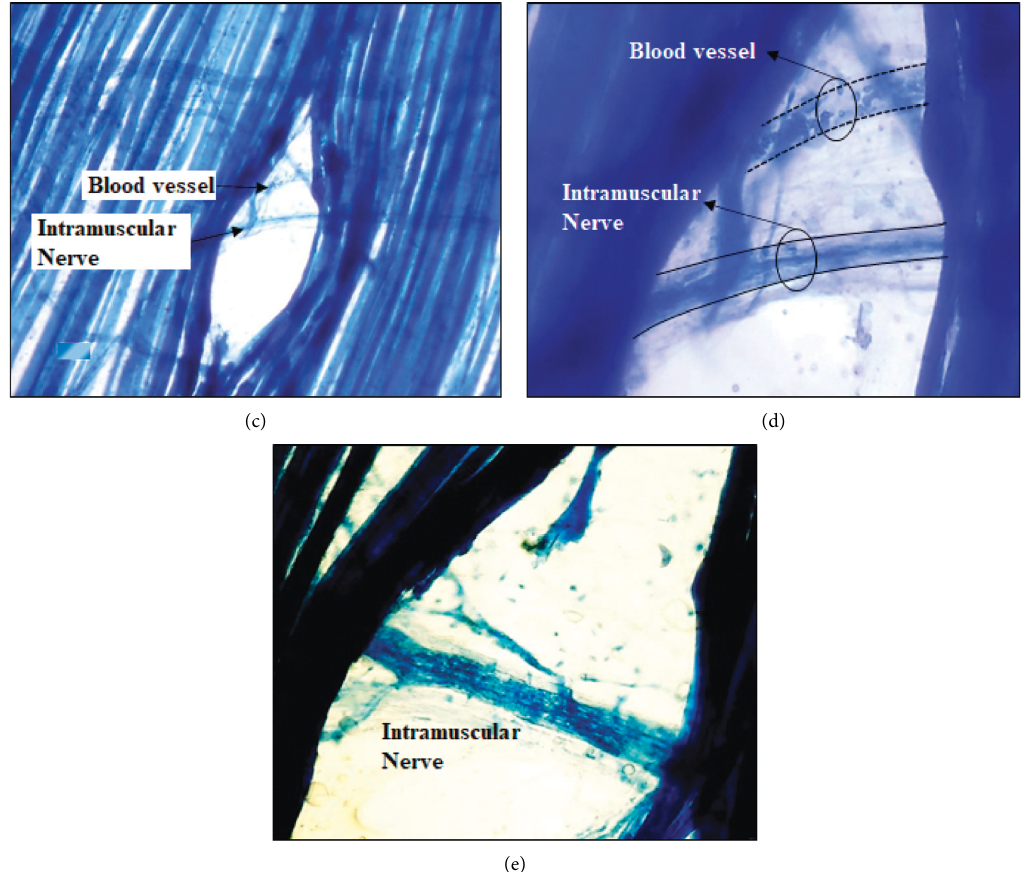
Figure 2: Ex vivo dry needling in LAL muscle with fibers with contraction knots. (a) Thirty minutes after a subcutaneous administration of neostigmine, the muscle shows several knots of contraction (arrows). (b) Several repeated punctures on the muscle were performed. Note that punctures were not performed at the same point. The needle separates many muscle fibers, and many others are injured (initial magnification: 100x). (c) Details of a puncture. Vessels and nerves in the puncture site can be seen without injury (initial magnification: 200x). Erythrocytes circulating through the vessel can be seen (d) (initial magnification: 400x). (e) Another example of puncture showing an intramuscular nerve without injury (initial magnification: